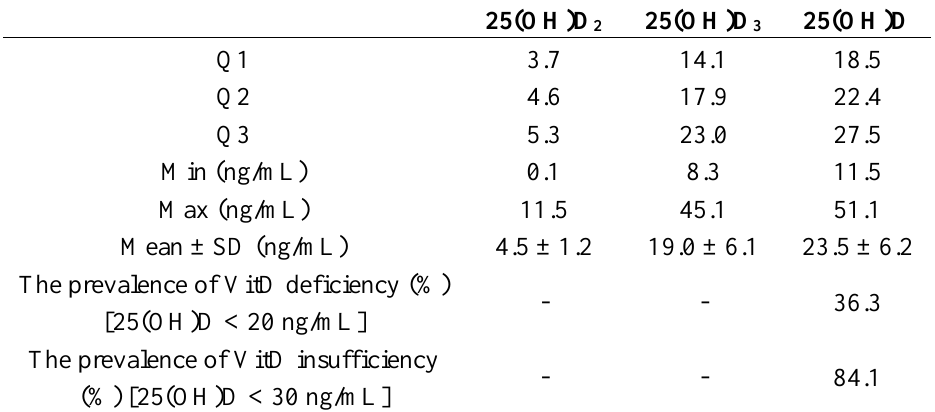
Table1. Vitamin D level and the prevalence of vitamin D deficiency in newborns ( n =